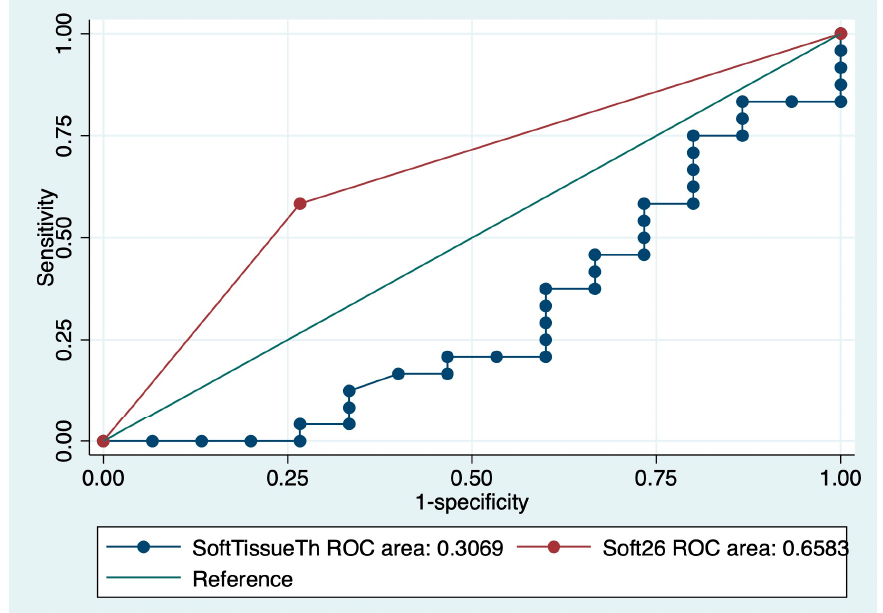
Figure 3. ROC curve of soft tissue thickness for IPF mortality.